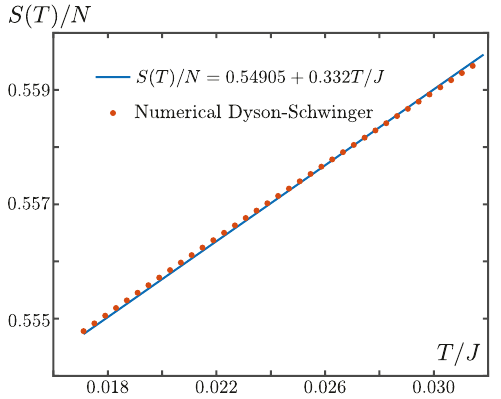
Figure 6 . A demonstration that the coupling obtained via the compressibility is consistent with a direct linear fitting of the entropy S ( βJ ) . The dots are the numerical entropy computed through numerical Dyson Schwinger solutions on a grid of size 2 20 . Due to finite size effects, we can not take T to be too small. We show a best fit with slope fixed to be the answer determined through compressibility. The intercept, S , is close to its analytical answer. We can also fit both the slope 0 and the intercept, and we obtain S ( βJ ) = 0 . 5493 + 0 . 3233 / ( βJ ) . The difference is about 2 . 7% and we conclude the answer determined both ways are consistent with each